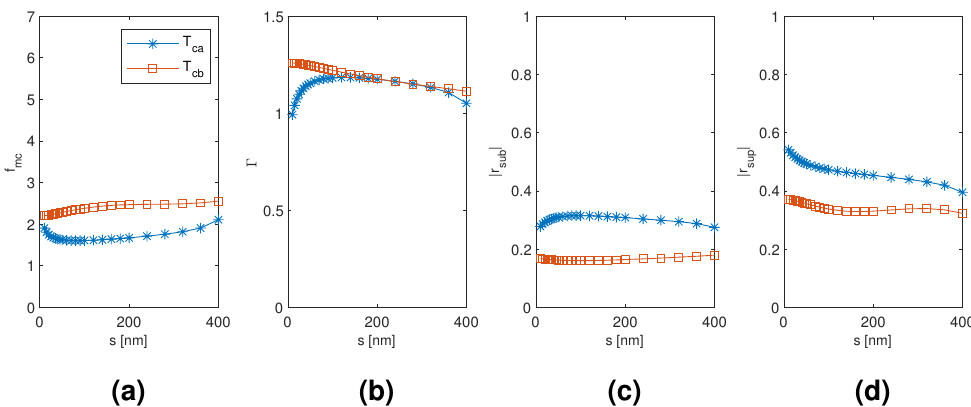
Figure 17. The results for the coated tetramer T ca and T cb mode as a function of the separation of the nanowires with the diameter of the nanowires and the coating thickness corresponding to the point of modal cost function minimum for each mode (as listed in Table 2). ( a ) modal cost function value; ( b ) modal confinement factor; ( c ) substrate modal reflection coefficient magnitude; ( d ) superstrate modal reflection coefficient